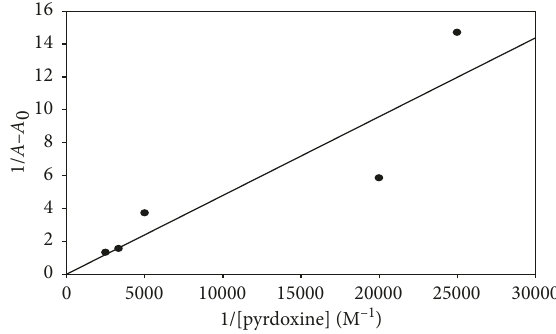
Figure 7: CV of 1.0 trode in 0.1M phosphate buffer/5mM NaCl supporting electrolyte (pH 7.0) at different scan rates. Scan rate: (a) 0.05V/s; (b) 0.1 V/s; (c) 0.2 V/s; (d) 0.3V/s; (e) 0.4V/s 0.5; (f) 0.6V/s.